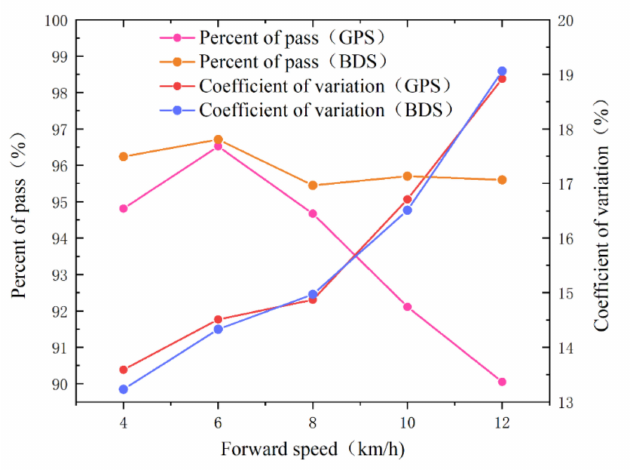
Figure 16. The influence of different speeds on the sowing qualification rate and the coefficient of